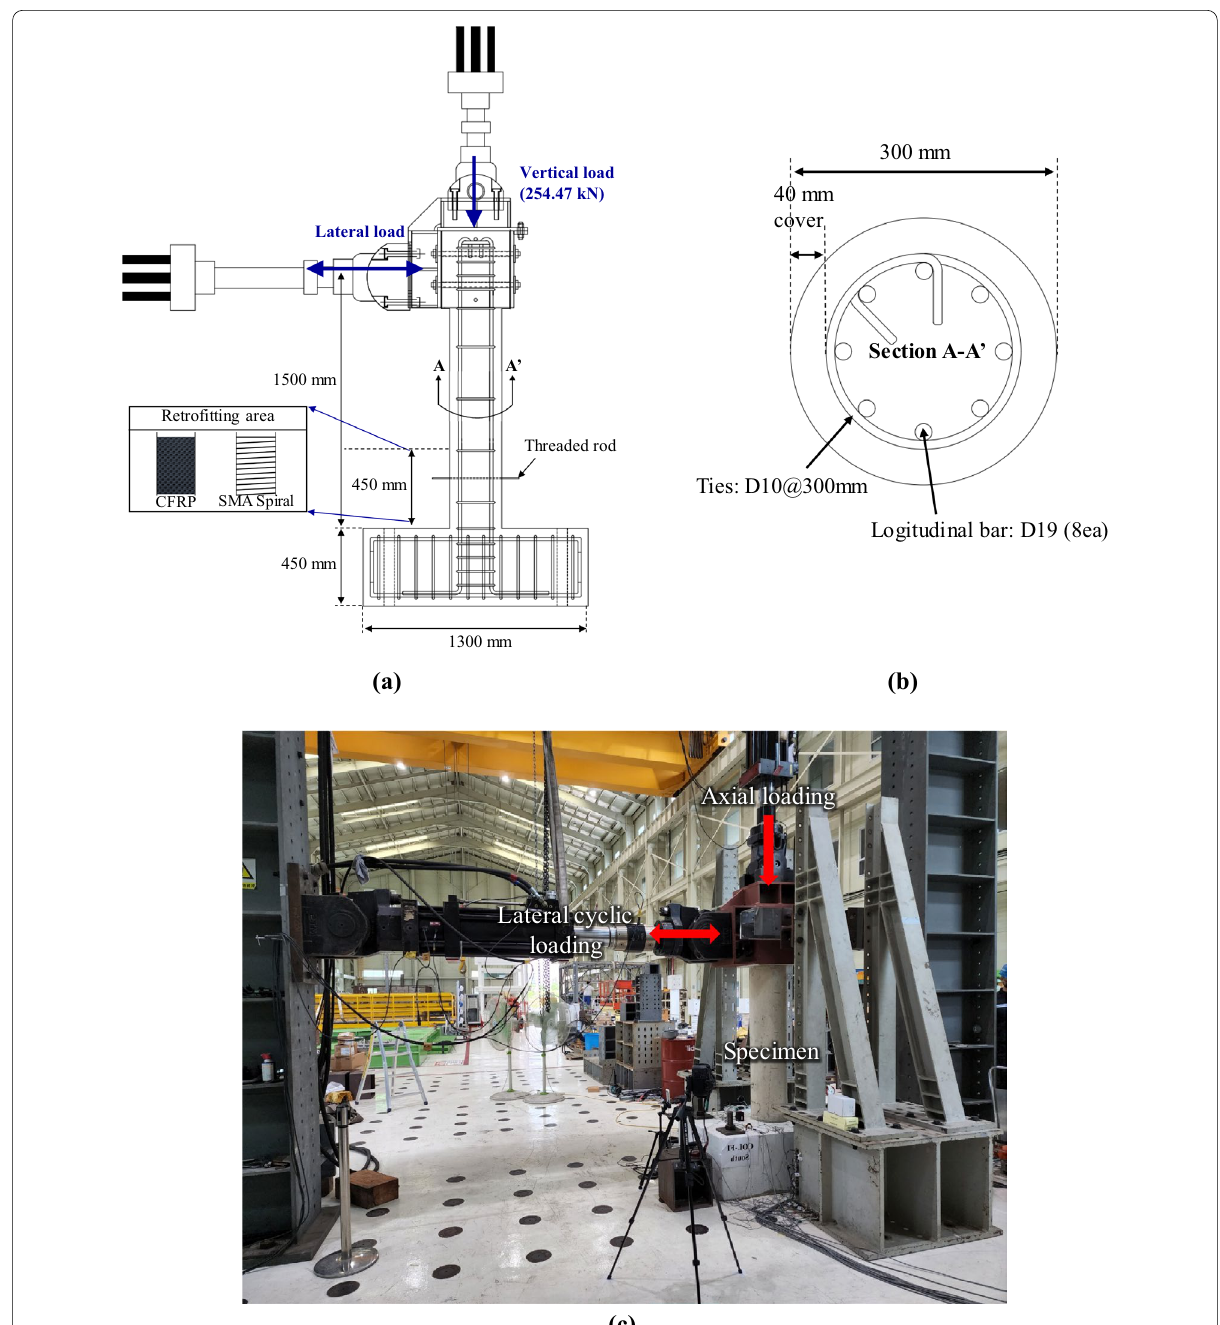
Fig. 5 Design of the RC columns and test setup. a Test setup; b cross-section of RC columns; c real photo of test